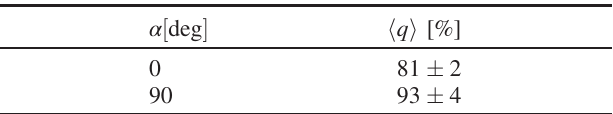
TABLE IV. Estimated trapped flux by analyzing expelled flux during phase transition using Eq. (1).